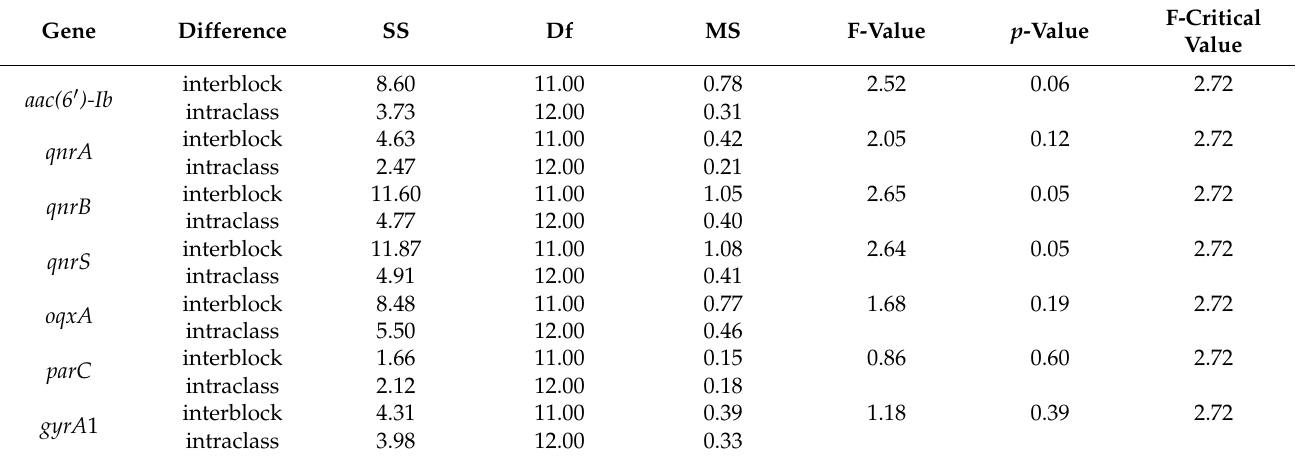
Table 3. Homogeneity parameters of plasmid DNA reference